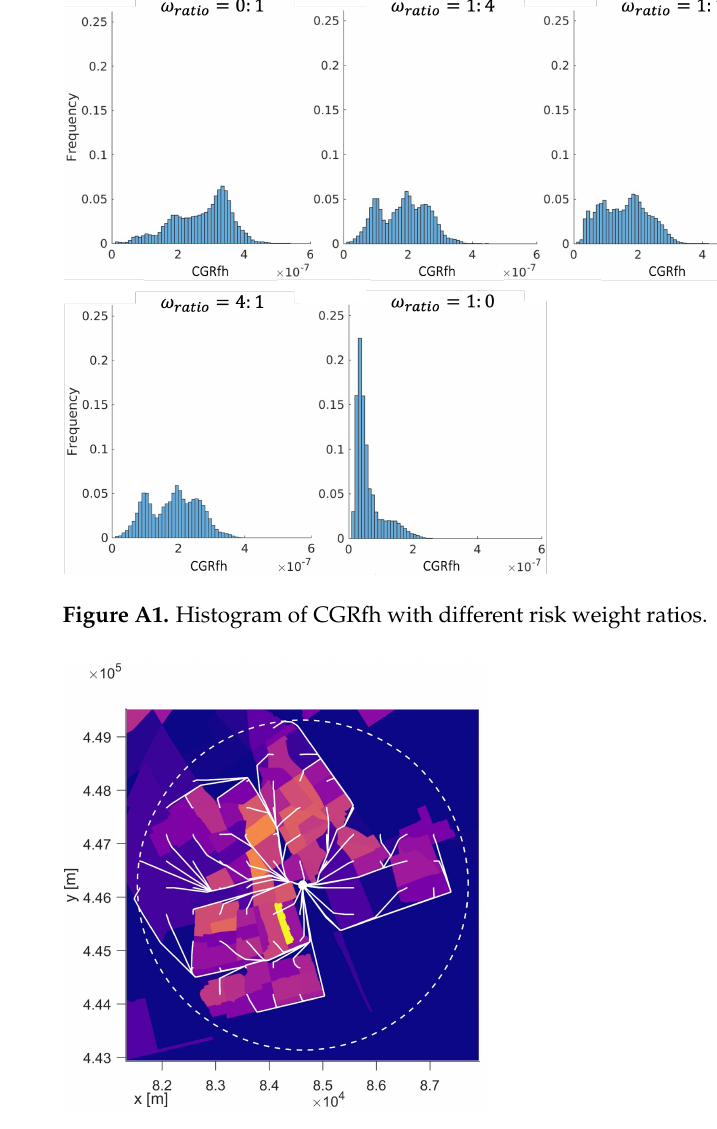
Figure A2. Generated paths for OD pairs in Experiment